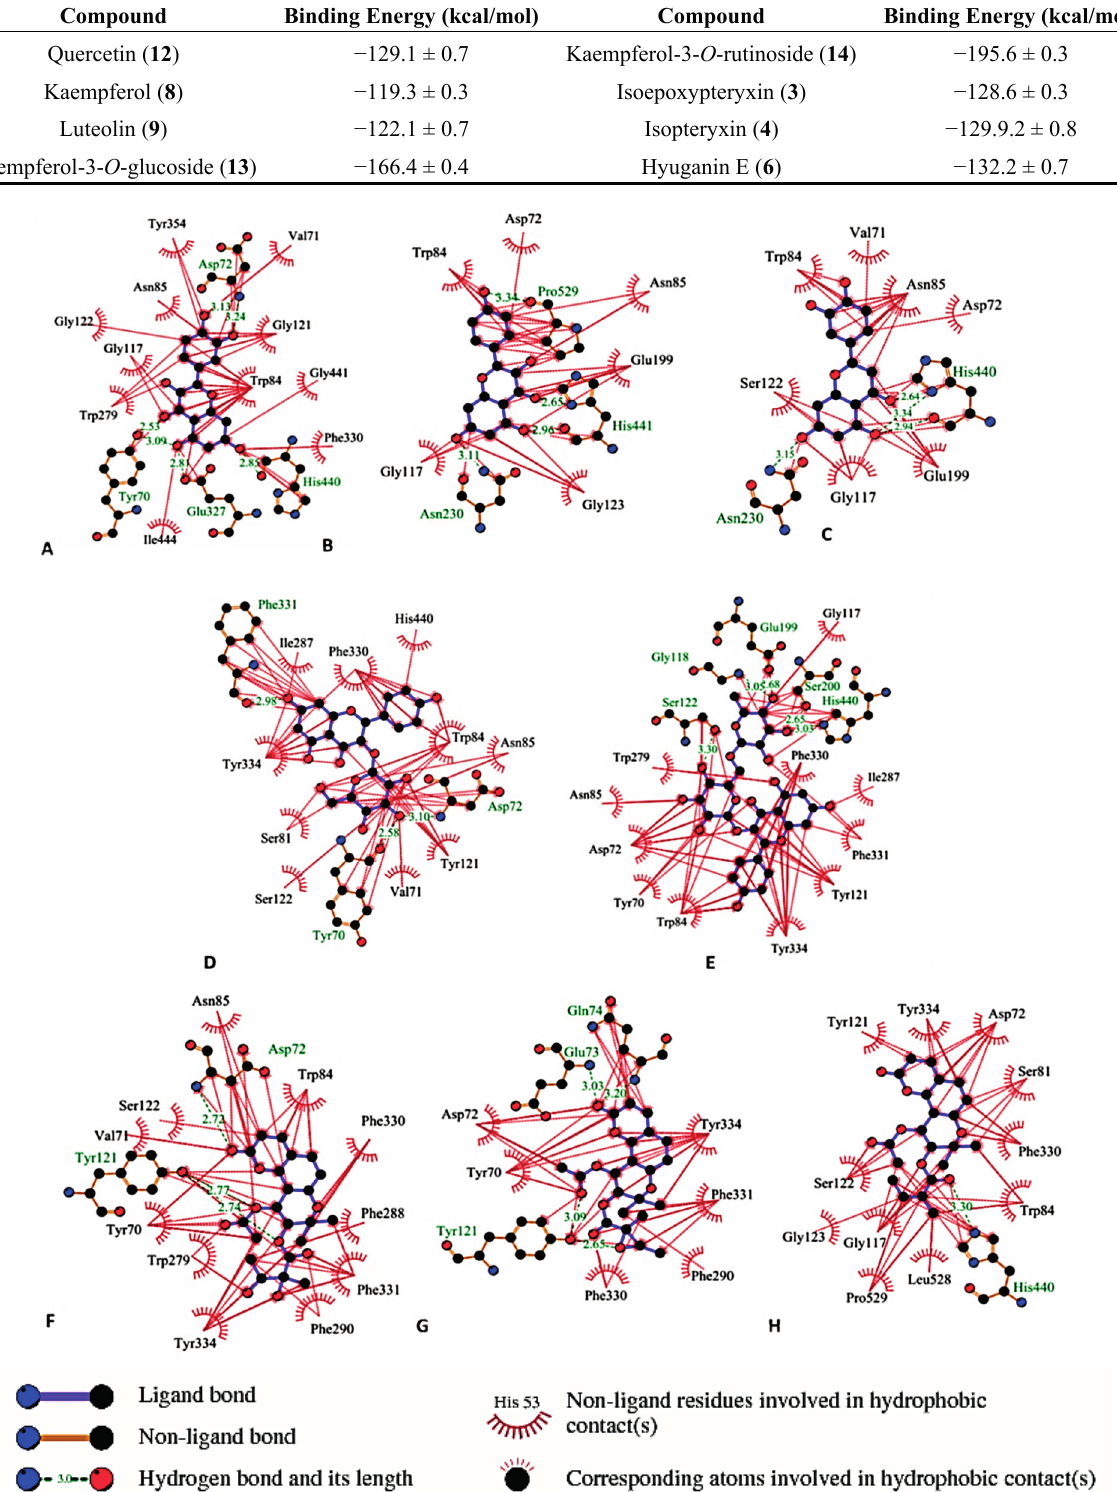
Figure 2. Binding residues of the active compounds in AChE assay using LigPlot+ v.1.4 program. ( A ) quercetin ( 12 ); ( B ) kaempferol ( 8 ); ( C ) luteolin ( 9 ); ( D ) kaempferol-3- O - glucoside ( 5 ) ( E ) kaempferol-3- O -rutinoside ( 14 ); ( F ) isoepoxypteryxin ( 3 ); ( G ) isopteryxin ( 4 ); ( H ) hyuganin E ( 6